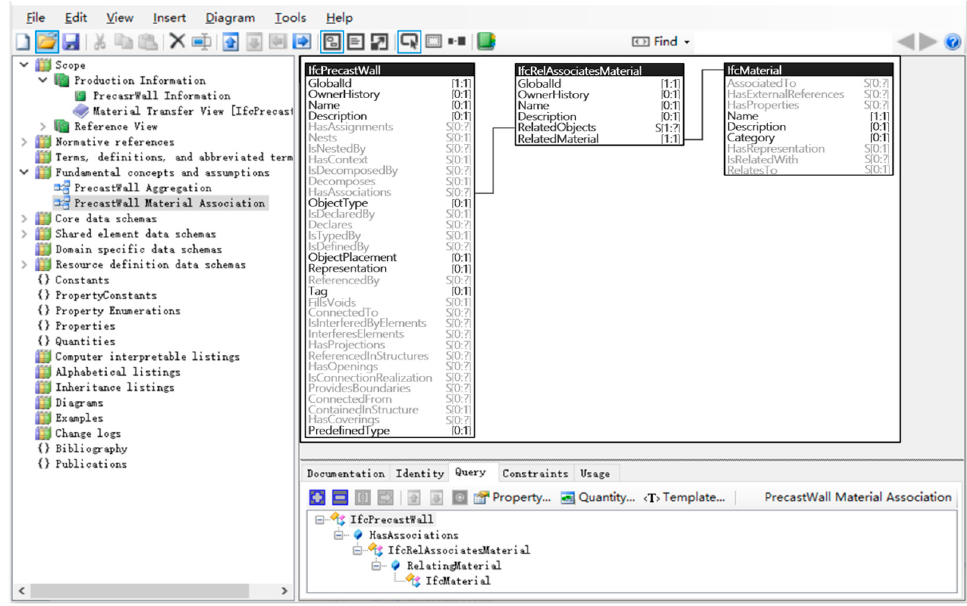
Figure 26. Entity and property model views of material association concepts for prefabricated wall.